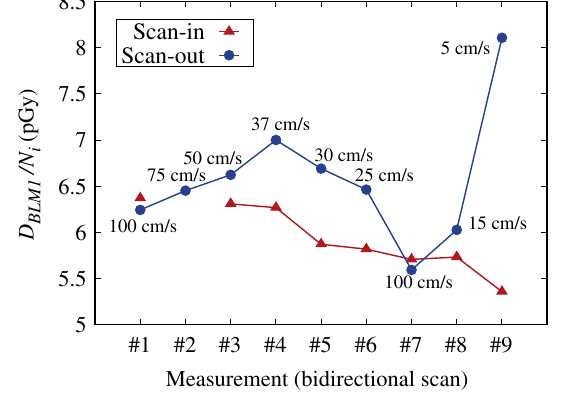
FIG. 5. Measured BLM dose divided by the number of inelastic nuclear collisions of protons in the LHC wire scanner predicted by Eq. (6). Each measurement consisted of a bidirectional scan, represented by separate points for the opposite scanning direc- tions. The wire speed was always 100 cm = s during the first of the two scans (triangles), while the second scan (circles) was performed at different speeds as indicated in the figure. For one of the scans (scan in for measurement number 2), no BLM data are available.